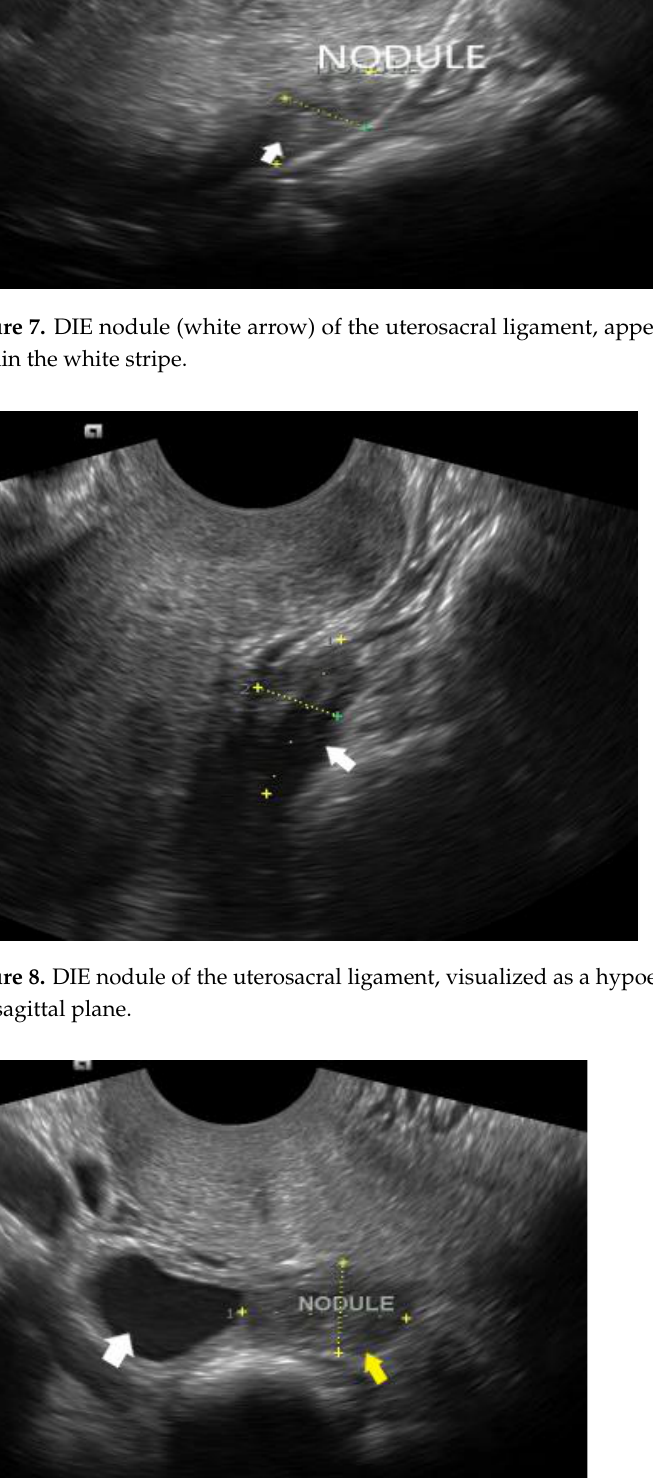
Figure 9. DIE nodule of the torus uterinus, appearing as a hypoechoic lesion on the rectrocervical area (yellow arrow). Adjacent to it, a hematosalpinx can be visualized (white arrow). With the probe in the posterior vaginal fornix, one can visualize forniceal endome- triosis lesions as hypoechoic thickening or nodules of the vaginal wall, above the line that passes through the lower edge of the posterior lip of the cervix. The DIE in the RVS distorts the normal hyperechoic (fat-filled) layer between the vaginal and anterior rectal wall, often extending to the vagina and/or the rectum. It has been suggested that DIE in the RVS should be suspected when a hypoechoic lesion is identified between the vagina and the rectum, below the line that passes through the lower edge of the posterior lip of